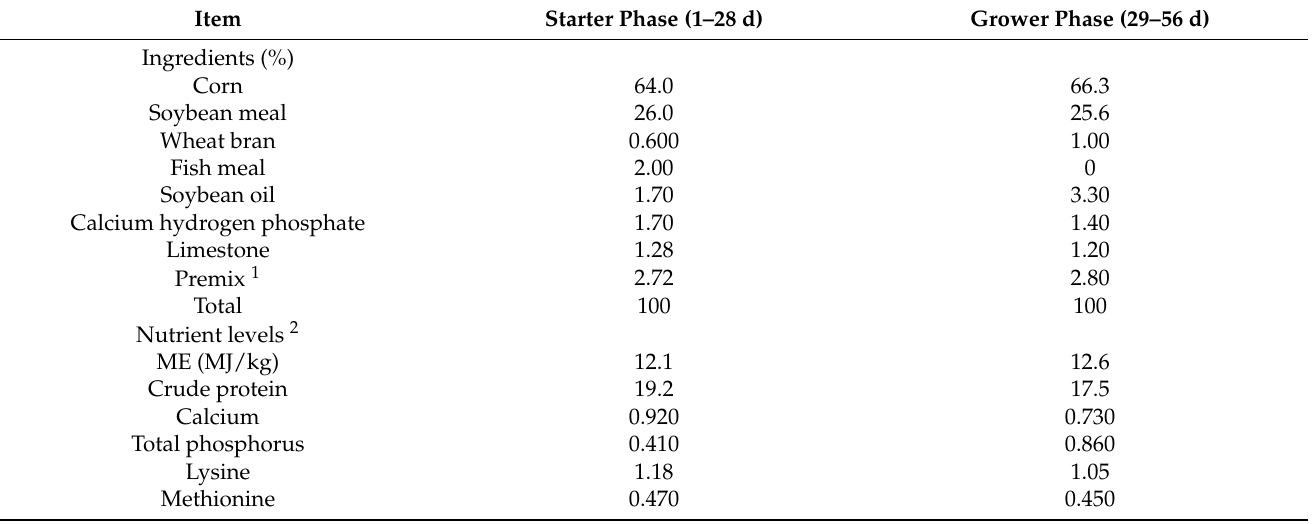
Table 2. Ingredients and nutrient compositions of experimental diets of starter and grower